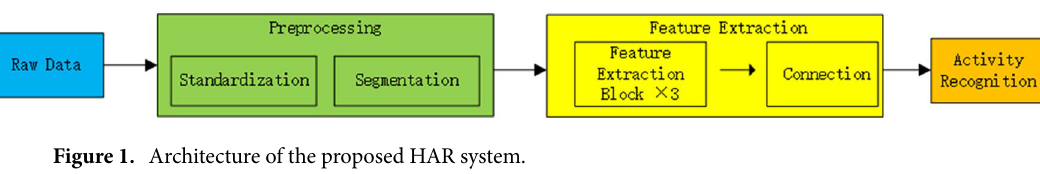
Figure 1. Architecture of the proposed HAR